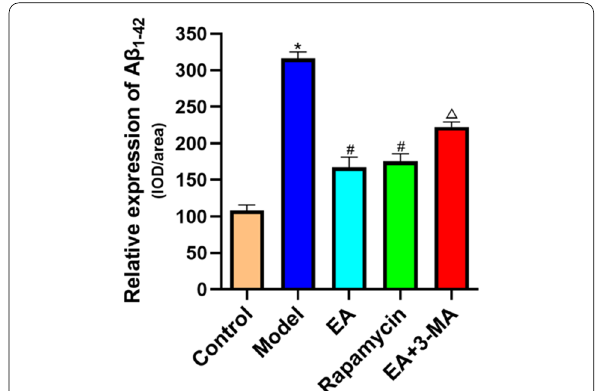
Fig. 5 Effect of EA on Aβ1-42 expression. Data are expressed as mean standard error of the mean ( n ± versus control group; # p < 0.05 versus model group; △ p < 0.05 versus EA group